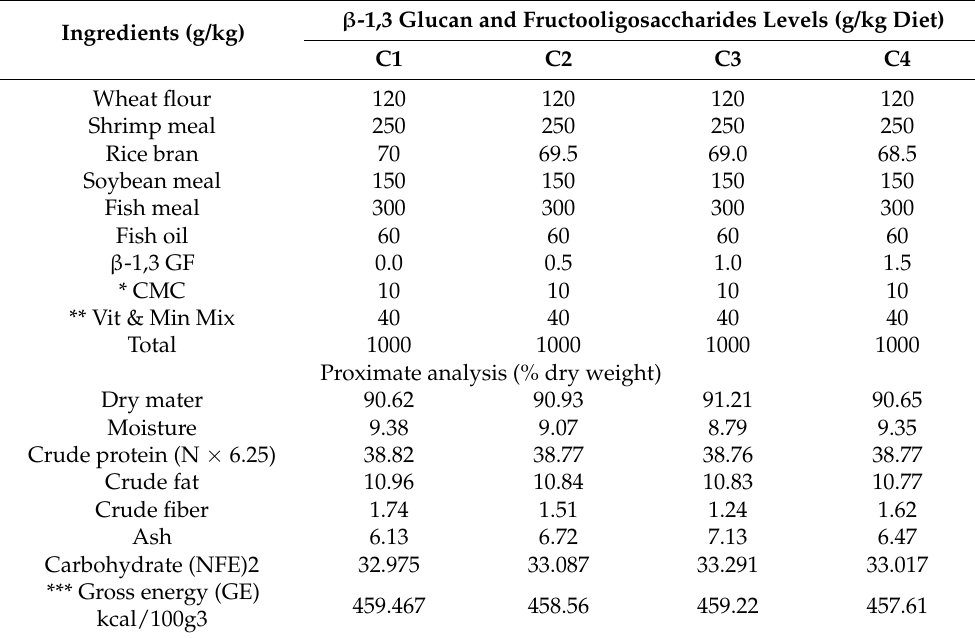
Table 1. Ingredients and proximate chemical analysis of the control diet (g/kg on dry matter basis). Ingredients